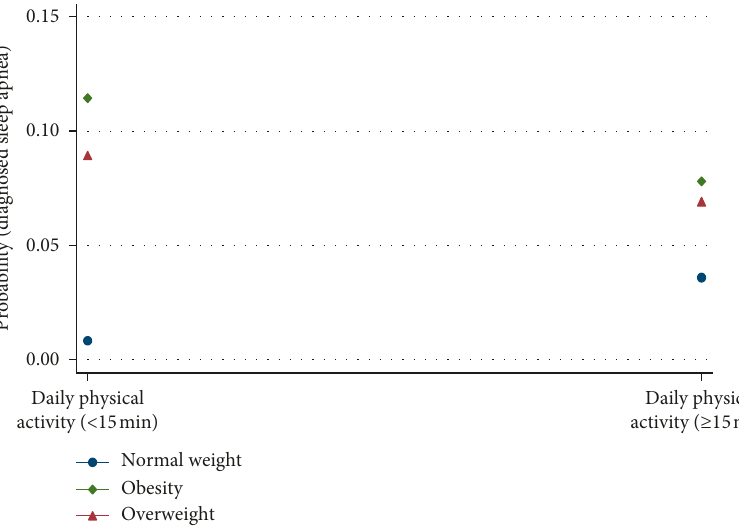
Figure 2: Predictive margins of BMI and physical activity. Y -axis—probability of diagnosed sleep apnea. X -axis—daily physical